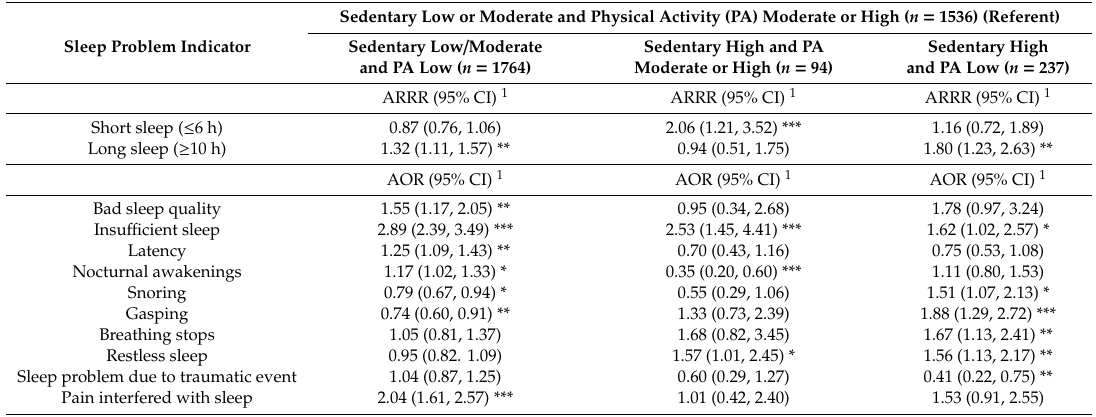
Table 3. Associations of combined sedentary behaviour and physical activity with sleep problem indicators. Sedentary Low or Moderate and Physical Activity (PA) Moderate or High ( n = 1536) (Referent) Sedentary Low / Moderate Sedentary High and PA Sedentary High Sleep Problem Indicator and PA Low ( n = 1764) Moderate or High ( n = 94) and PA Low ( n =